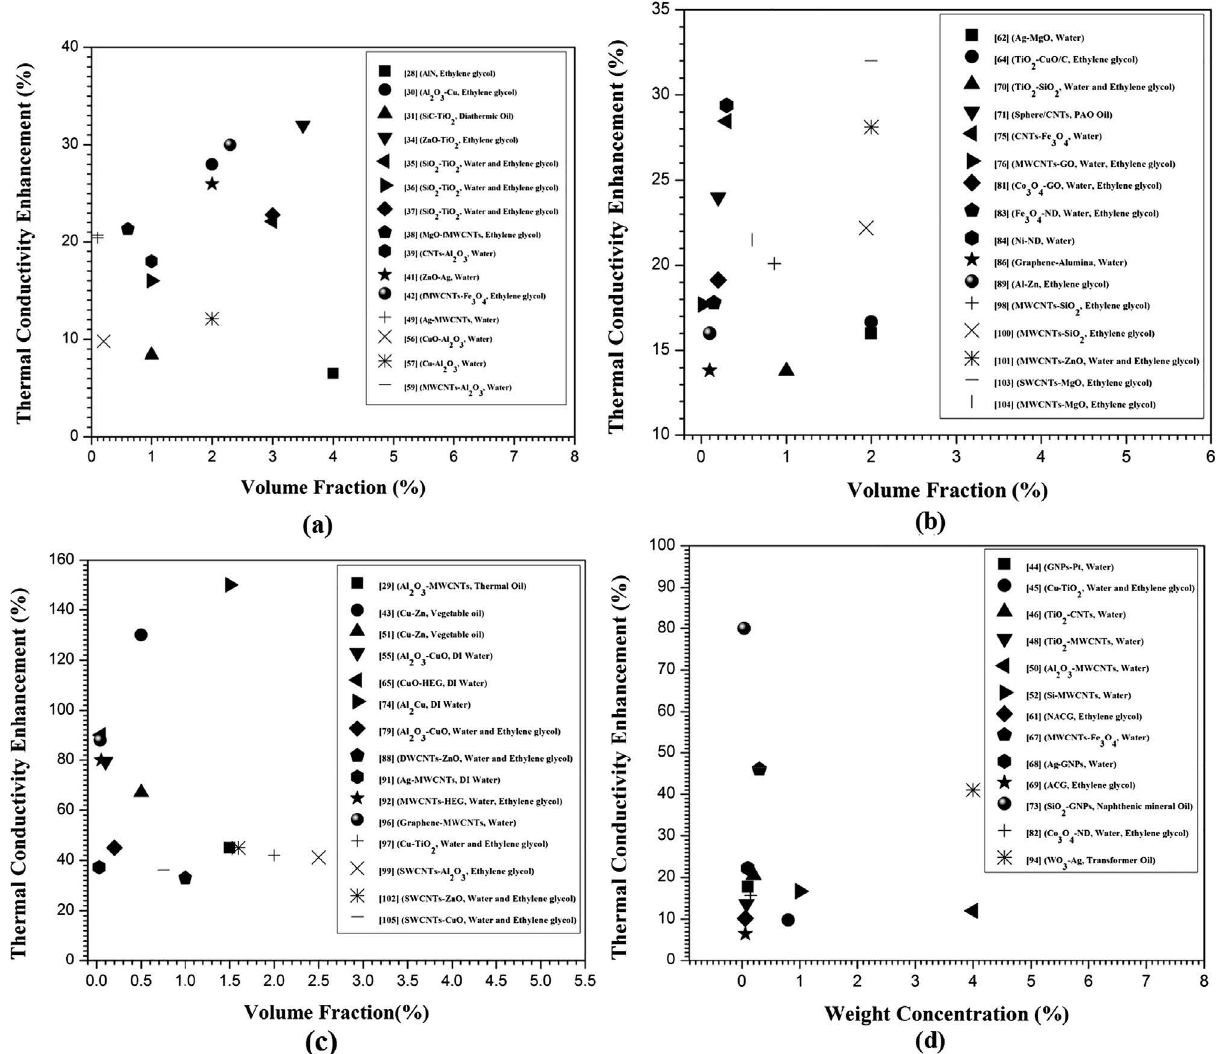
Figure 4. Enhancement of thermal conductivity using hybrid nanofluids; ( a – c ) mirror an accelerated thermal conductivity as a feature of the quantity fraction of the thermal conductivity improvement obtained via researchers ( d ) as a characteristic of the obtained weight fraction